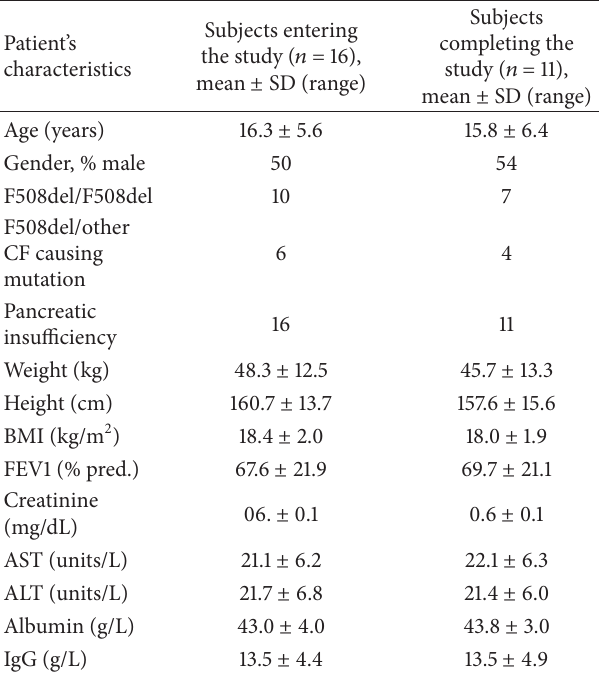
Table 1: Characteristics of CF patients beginning the study ( 𝑛 = 16) and of the subjects who completed the study and were eligible for evaluation ( 𝑛 =